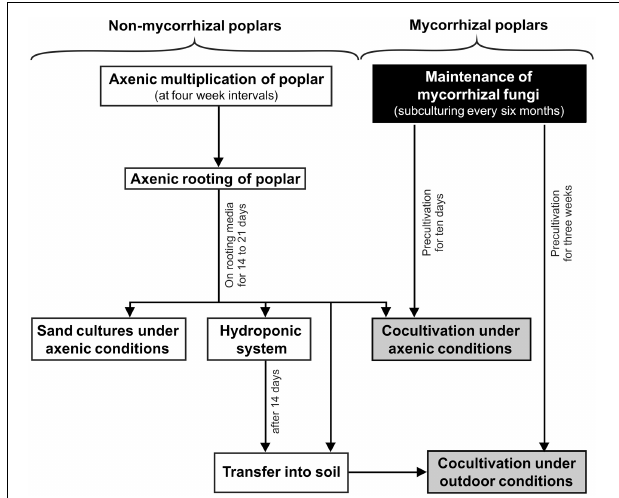
FIGURE 1 | Flow chart for growing poplars ( Populus sp .) under mycorrhizal or non-mycorrhizal conditions. The chart displays poplar growth conditions for axenic or outdoor cultivation (white color), for the cultivation of mycorrhizal fungi (black color), and the co-cultivation of mycorrhizal fungi and poplar (gray color). Approximated cultivation times are indicated.